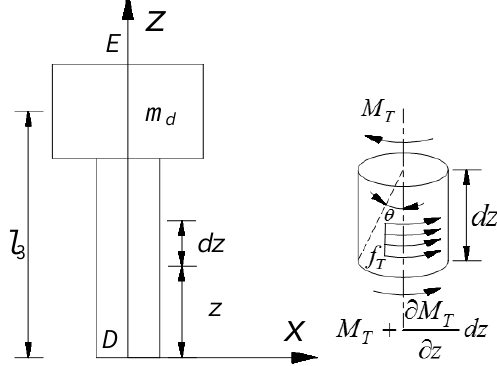
Figure 8. Free vibration model of intermediate shaft.